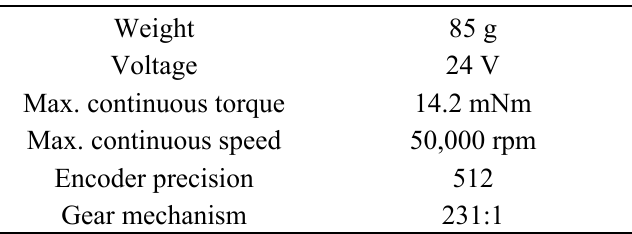
Table 1. Characteristics of the actuator